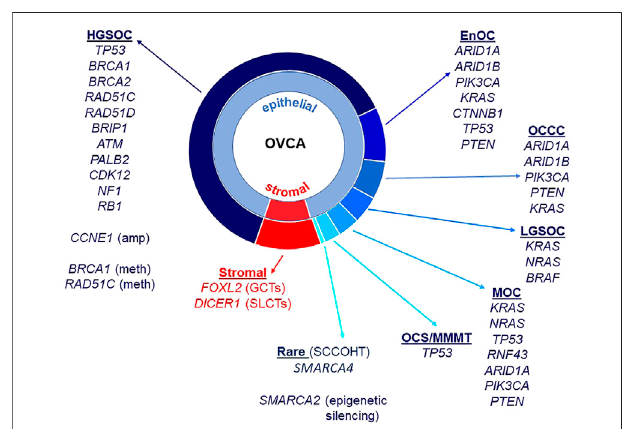
FIGURE 1 | Ovarian cancer histotypes and gene mutations. Epithelial ovarian cancers constitute approximately 90% of all malignant ovarian tumors and are made up of different histotypes: high-grade serous ovarian cancer (HGSOC), endometrioid ovarian cancer (EnOC), ovarian clear cell carcinoma(OCCC), low-grade serousovarian cancer(LGSOC)and mucinous ovarian cancer (MOC). Ovarian carcinosarcomas (OCS)/malignant mixed mullerian tumors (MMMT) have epithelial and mesenchymal components. Stromal cell tumors include granulosa cell tumors (GCT, adult and juvenile) as well as Sertoli-Leydig cell tumors (SLCTs). Small cell carcinoma of the ovary, hypercalcemic type (SCCOHT) are a rare histotype. Gene mutations, copy number ampli fi cations, methylation and other epigenetic silencing are noted against